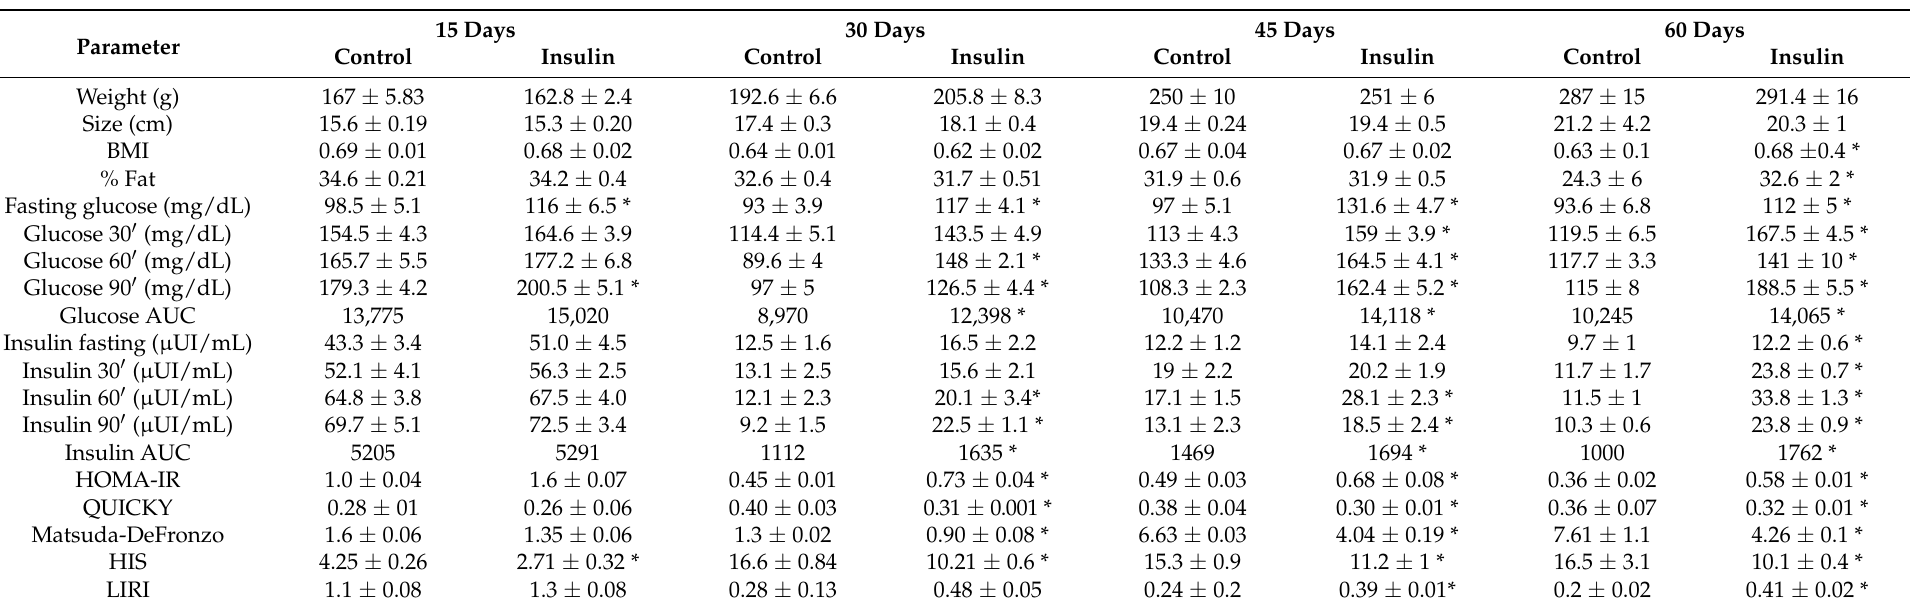
Table 1. Zoometry, oral glucose tolerance, insulin response, resistance, and sensibility